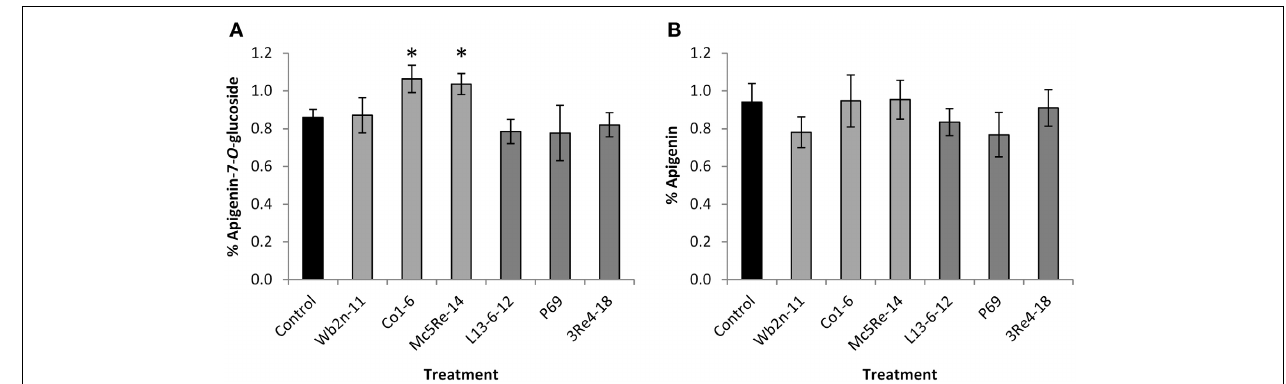
FIGURE 1 | Content (%) of apigenin-7- O -glucoside (A) and apigenin (B) in Chamomilla recutita (L.) Rauschert samples. Averages of individual HPLC-MS measurements and confidences are shown. Significant differences ( p < 0 . 05) of bacterial treatments ( Streptomyces